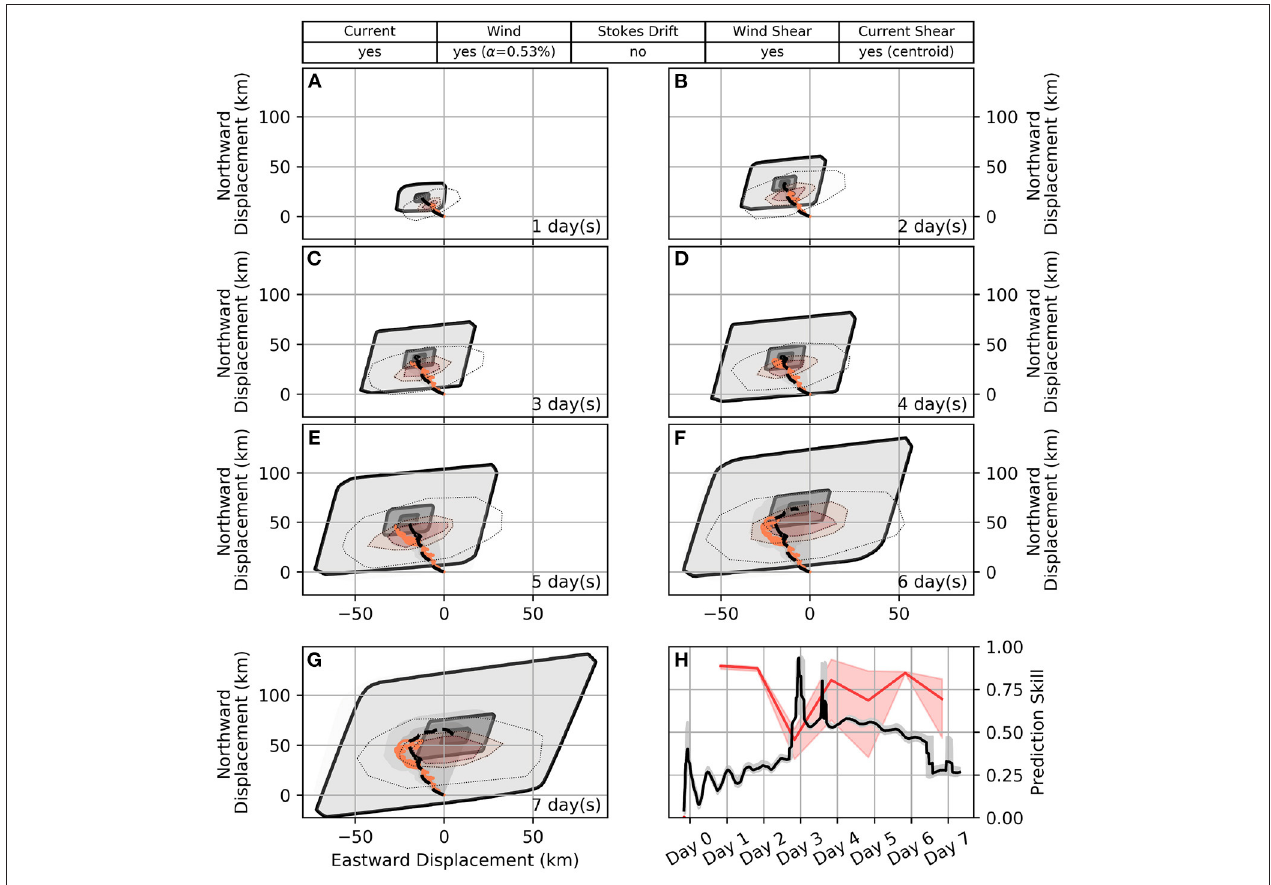
FIGURE 11 | Daily predicted tracks of the Davis drifters for 7 days after deployment using the indicated optimal forcing combination (A–G) , and a time series of model skill during this period (H) . Same layout as Figure 9